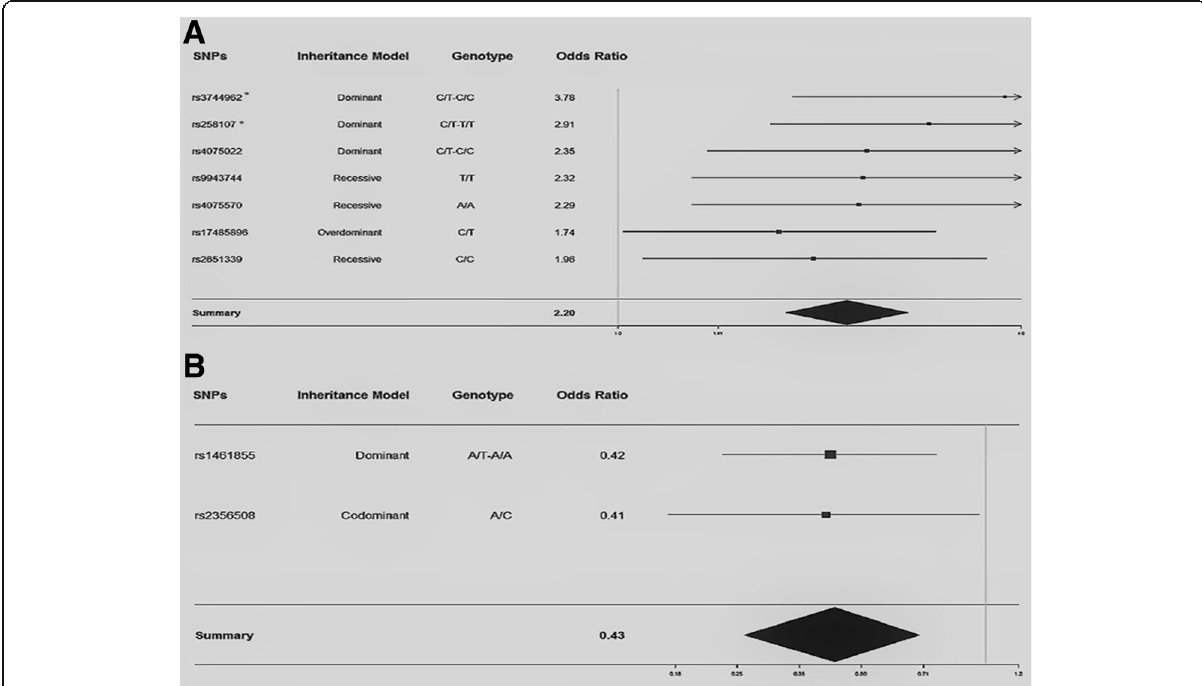
Fig. 1 Associations between 9 SNPs and thyroid cancer susceptibility analyzed by the Forest plot. a All SNPs that show significant risk associated with thyroid cancer development. b All SNPs that show significant protection against thyroid cancer development. The summary represents a combination of SNPs that show risk or protection regarding cancer